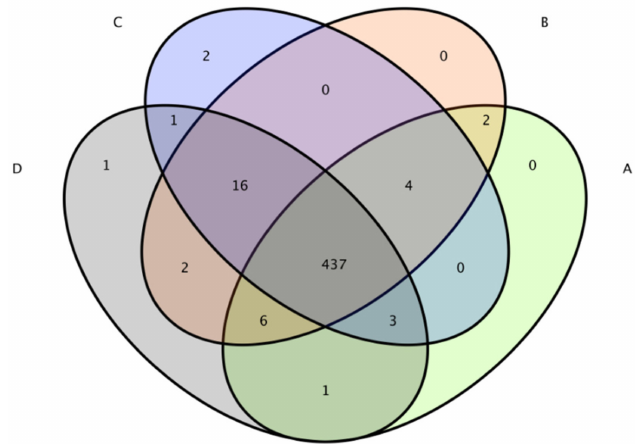
Figure 7. Venn diagram. Note: A: CON group, B: L.S group, C: E. coli group, D: L.S + E. coli